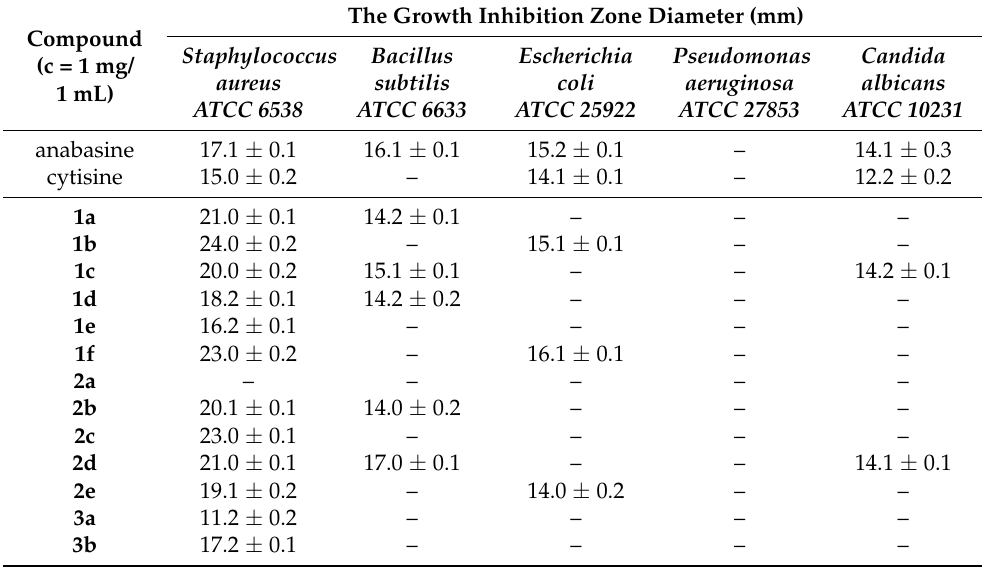
Table 2. Antimicrobial activity of the samples 1a – f , 2a – e , 3a – c , 3f based on agar diffusion studies.